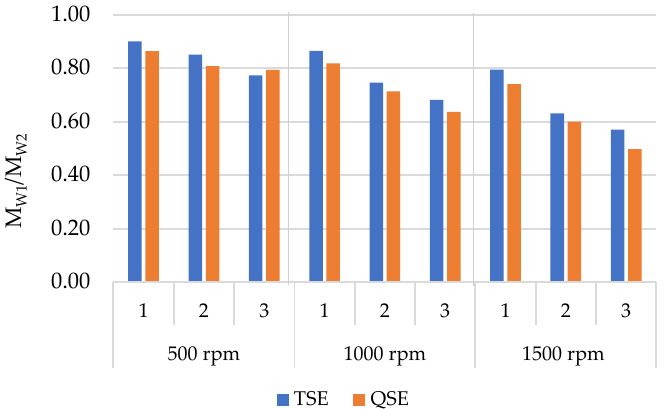
Figure 5. Molecular weight ratio (M W1 /M W2 ) for polypropylene reprocessed in a TSE and a QSE using three screw speeds and three reprocessing cycles.